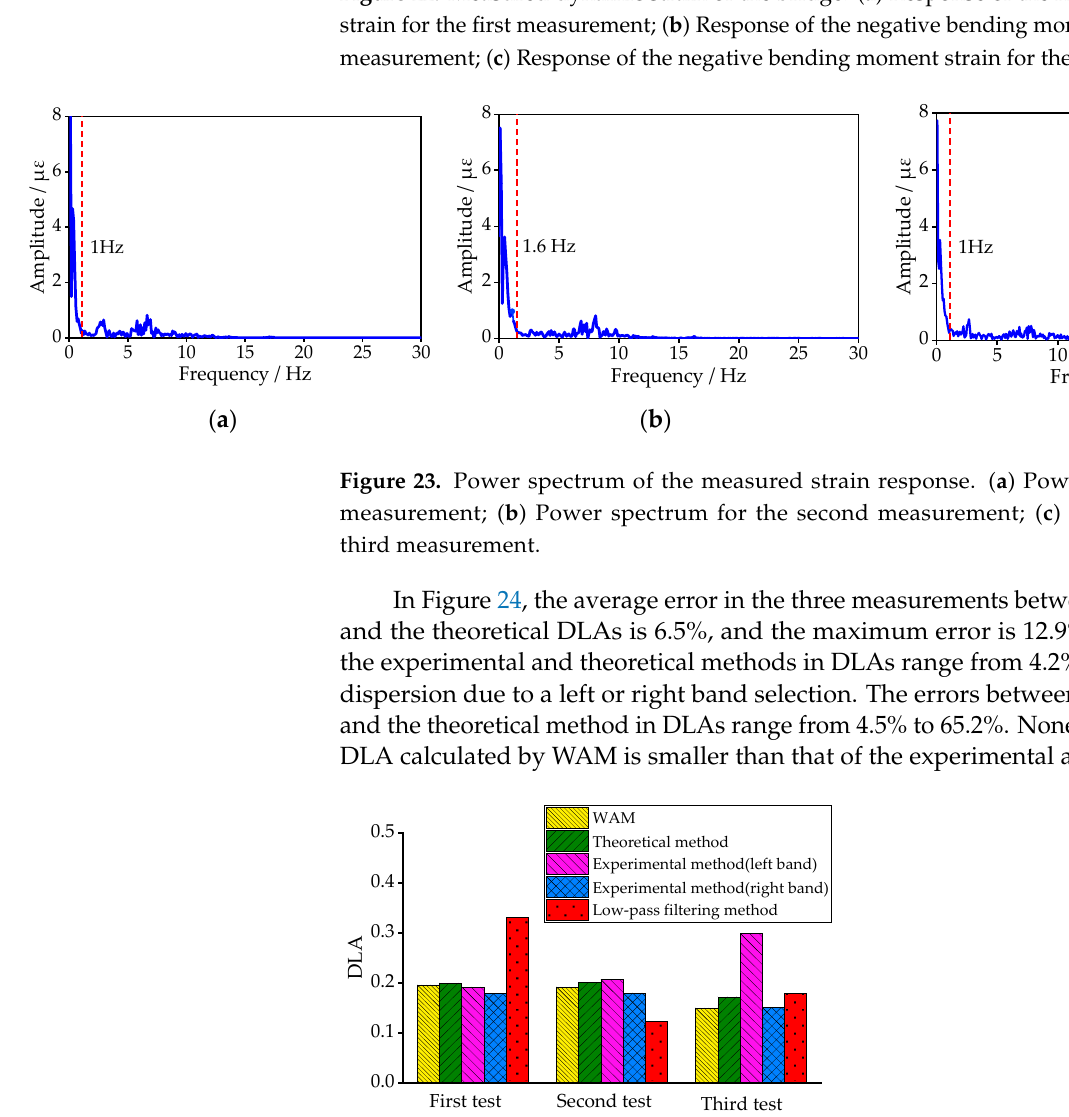
Figure 24. Comparison of DLAs from various methods.